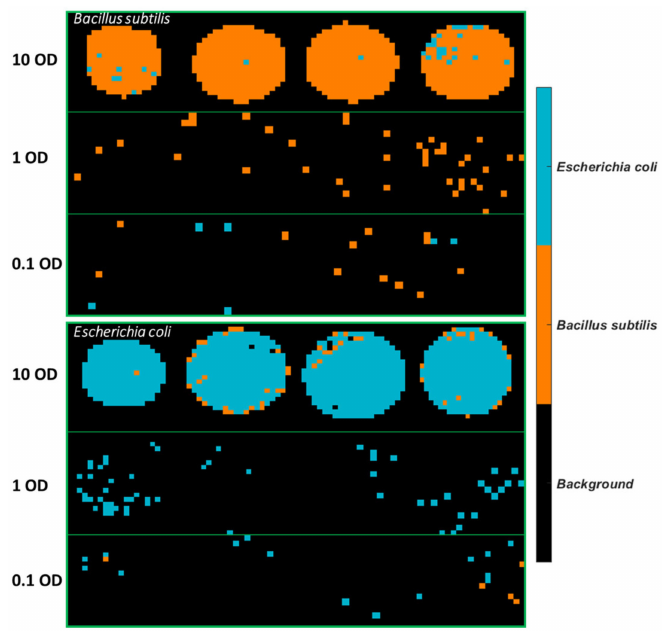
Figure 9. Classification maps obtained from the PLSDA model using 3500–2600 cm − 1 for samples deposited on Al with the 1 OD samples as the training set.